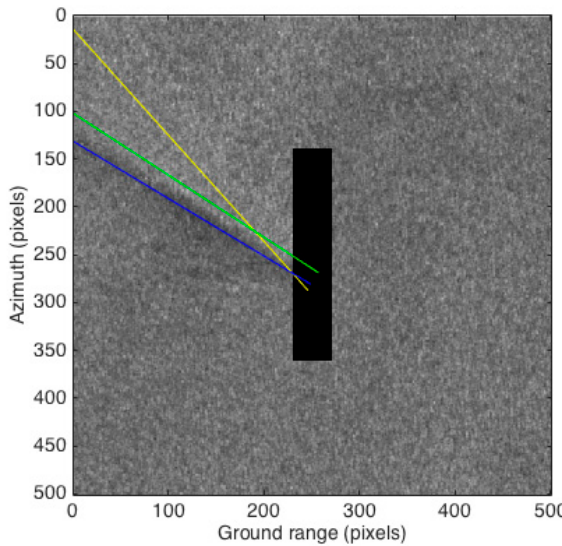
Figure 6. Reconstructed wake. Only the true features are displayed. The turbulent wake is shown in blue, the narrow-V wake in green, and the Kelvin arm in yellow. The black rectangle includes the masked pixels, excluded from the detection process.